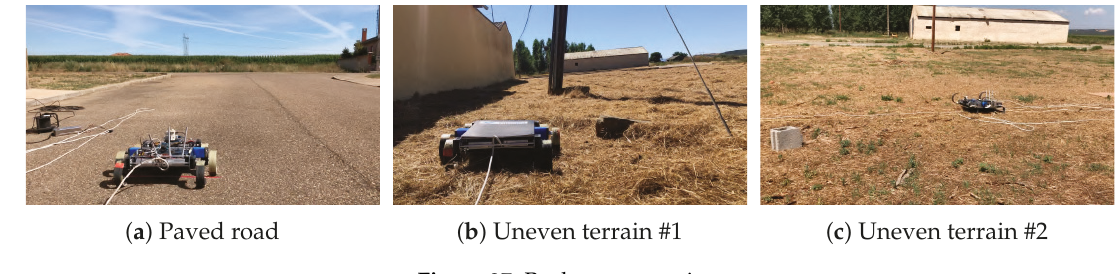
Figure 27. Real tests scenarios.